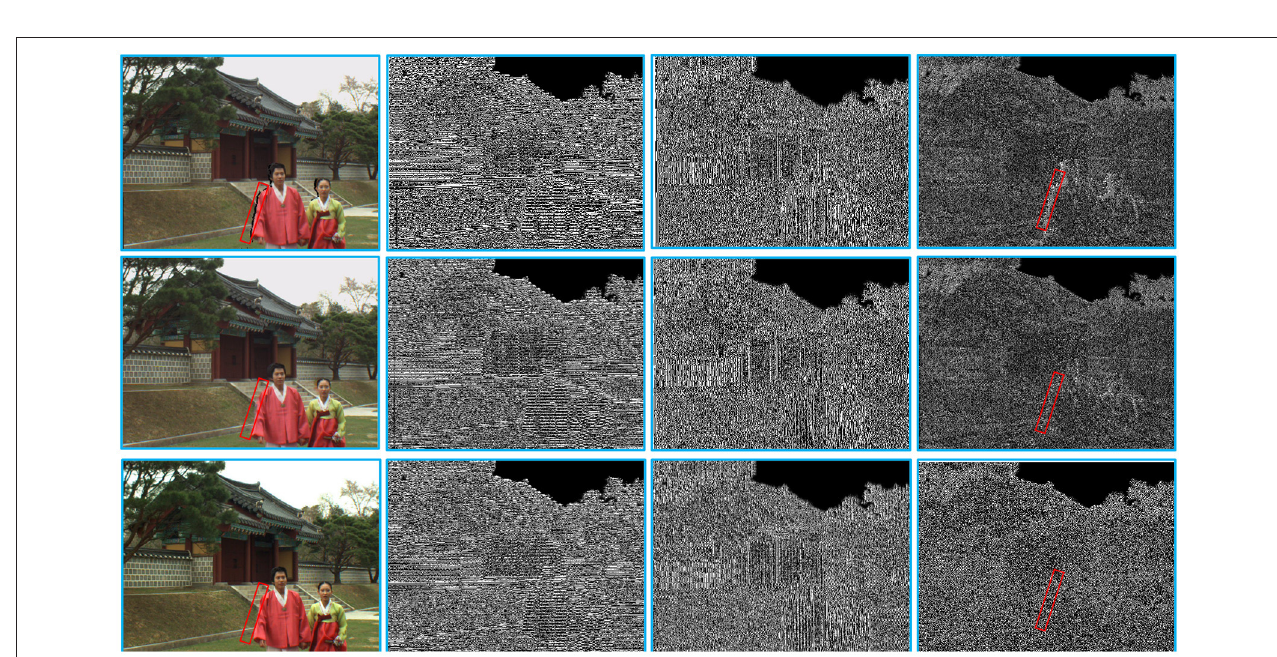
FIGURE 2 | Framework of the proposed TDI metric for predicting the quality of DIBR-synthesized images.